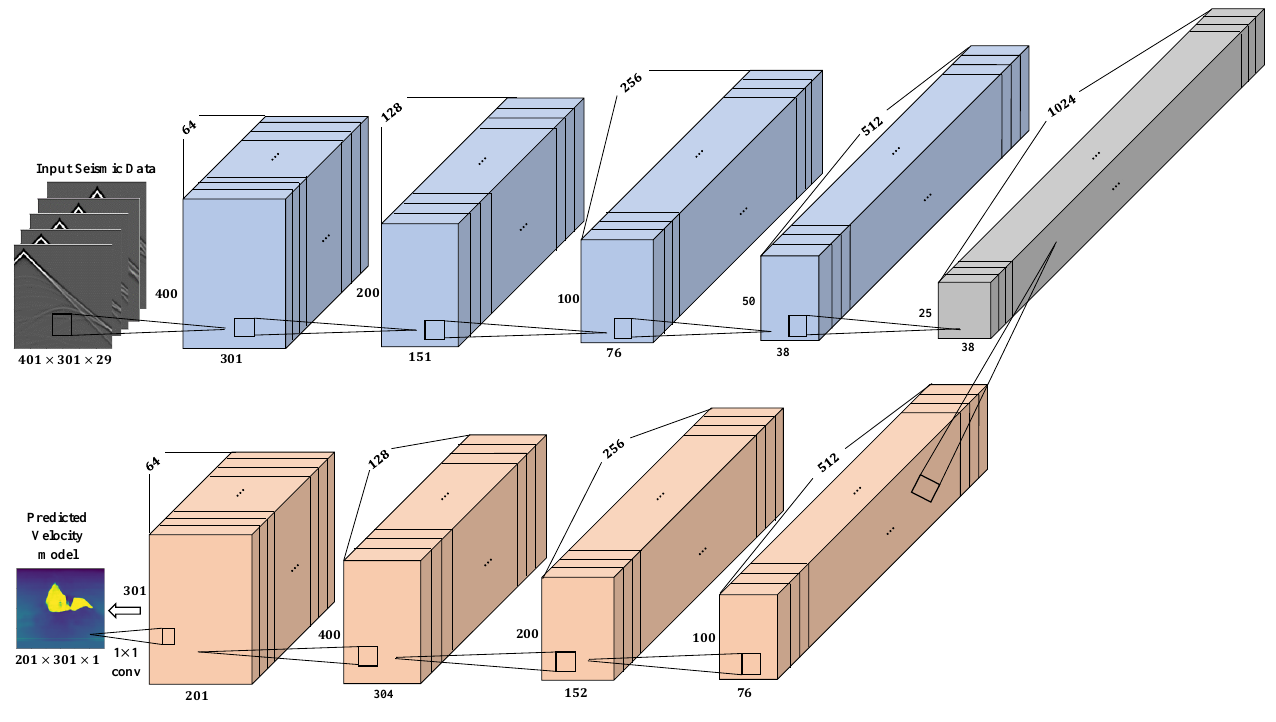
Figure 4. Modified UNet architecture used for the seismic inversion.